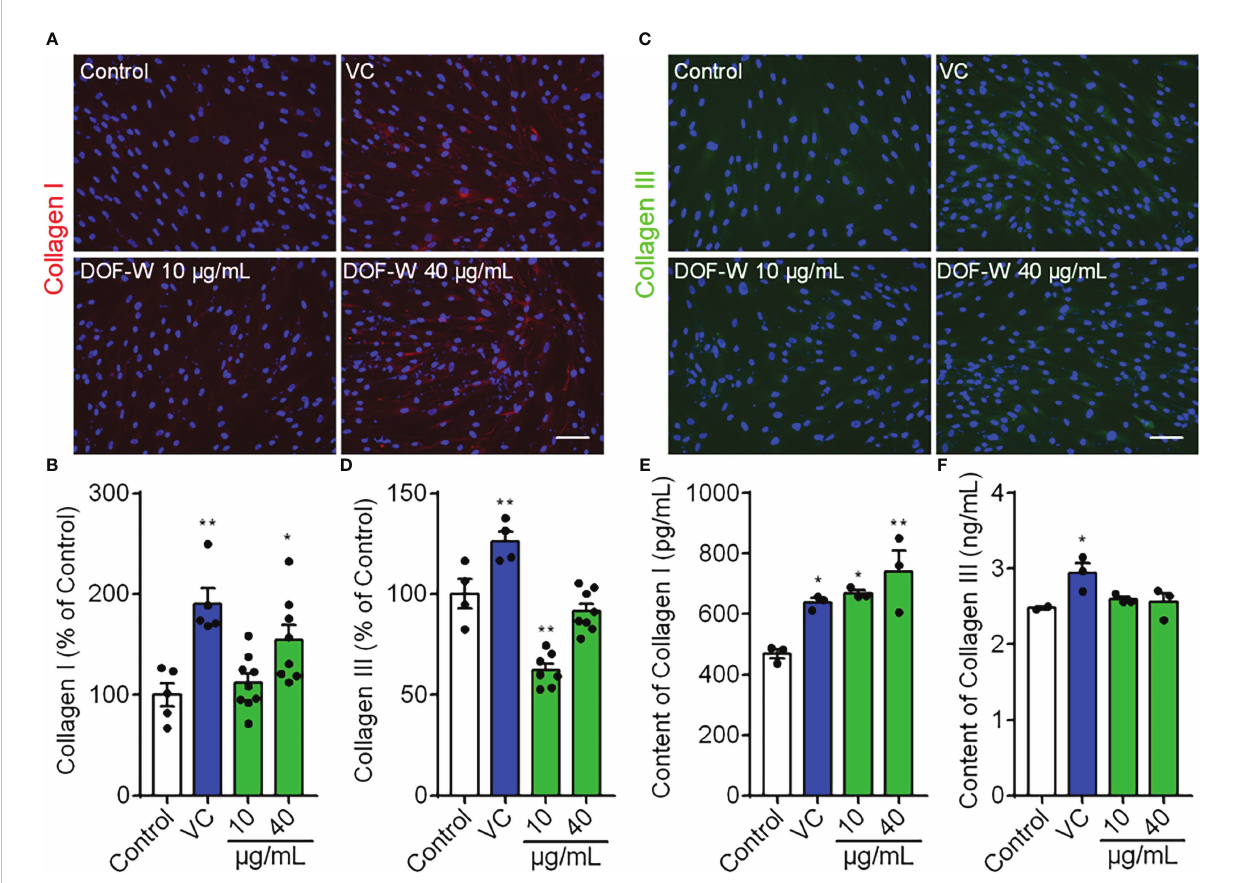
FIGURE 5 Effects of DOF extract on the expression of collagens by IF staining. HDFs were treated with VC (200 m g/ml, positive control) and DOF extract (10 and 40 m g/ml), whereas HDFs were incubated without any treatment as the control group. (A) Images of collagen I staining (red color) and quanti fi cation (B) . (C) Images of collagen III staining (green color) and quanti fi cation (D) . Extracellular content of types I (E) and III (F) collagen on HDFs using ELISA. Bar scale, 100 m m. Compared with the control group, * p < 0.05, ** p <